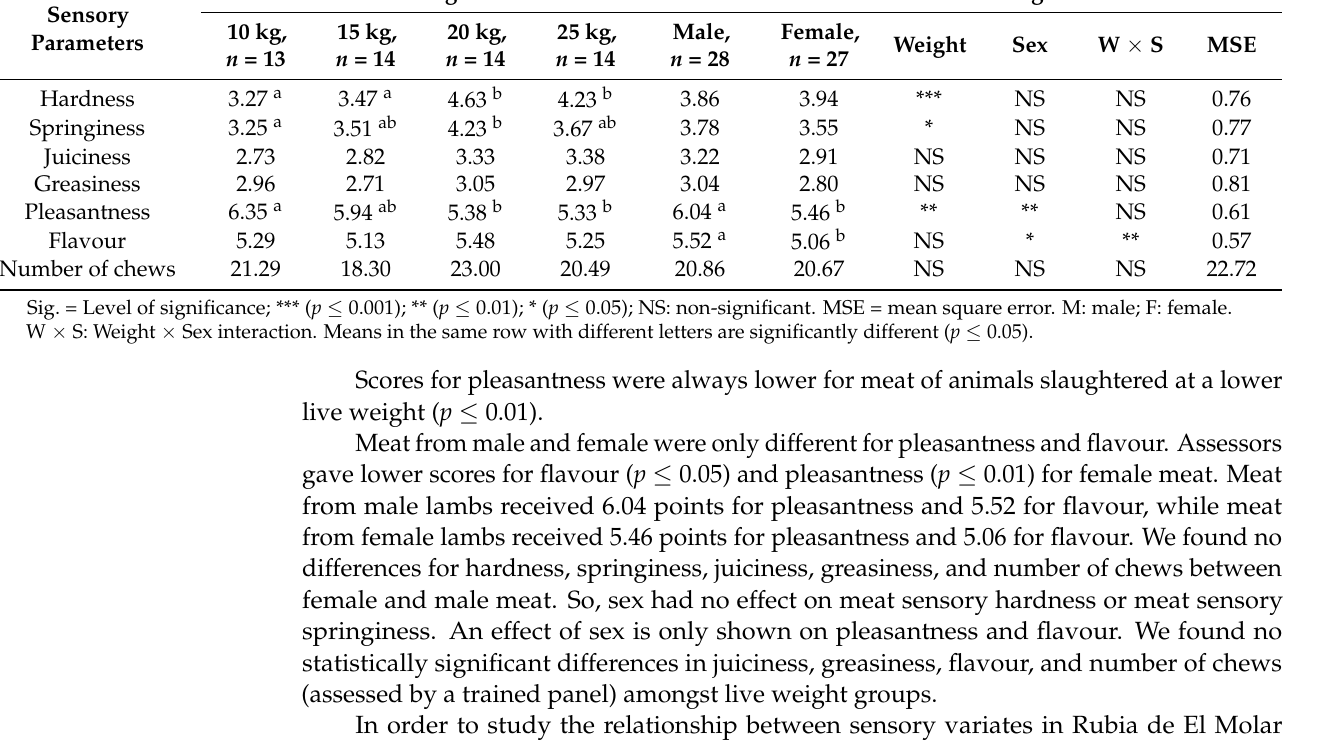
Table 2. Means and mean square error (MSE) of the sensory parameters of Rubia de El Molar lambs’ meat in the four weight groups and in male and female groups.